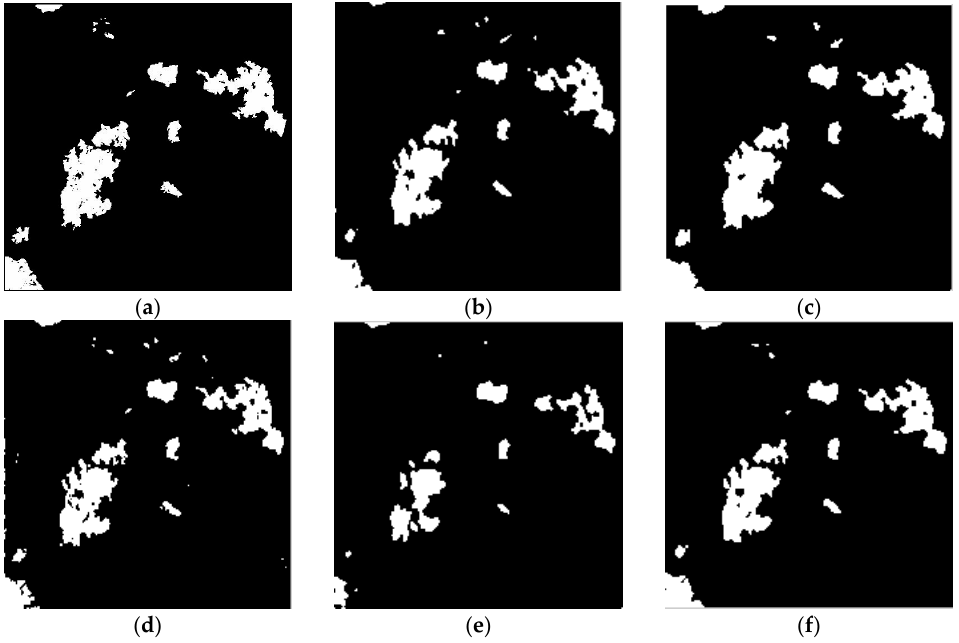
Figure 9. Change detection images obtained for the Mexico data set: ( a ) The reference change image; ( b ) NSCT-FCM; ( c ) MRF-FCM; ( d ) PA-GT; ( e ) PCA-NLM; ( f ) Proposed algorithm.